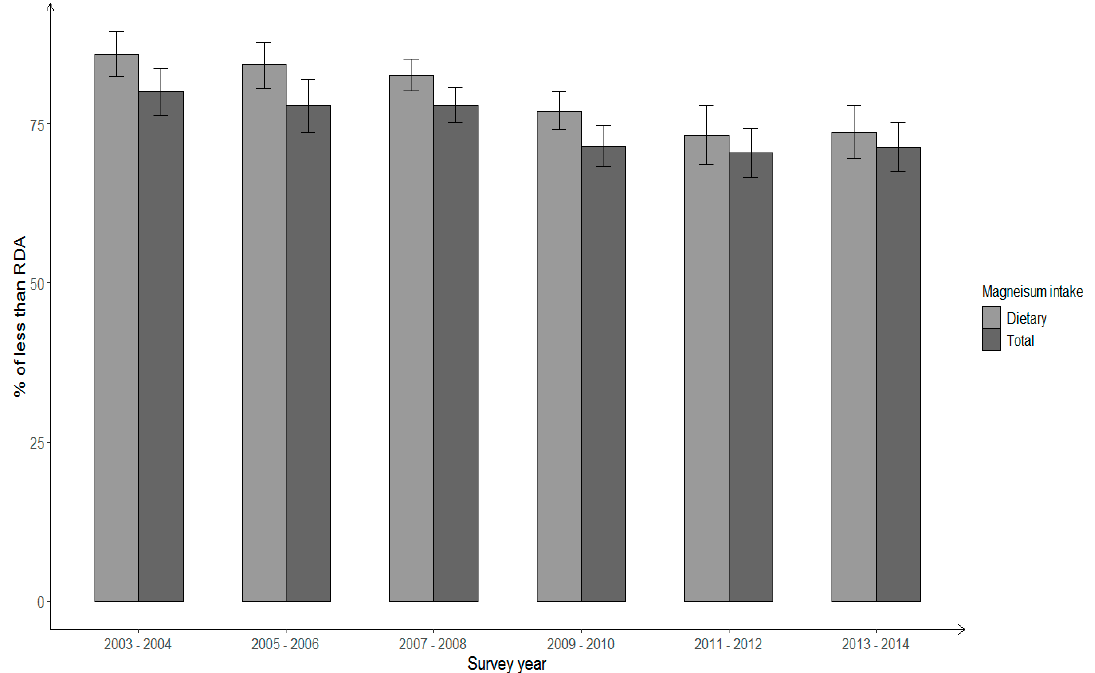
Figure 1. Percentage of insufficient dietary and total magnesium intake among Hispanic males aged ≥ 20 years across NHANES survey years 2003–2014.